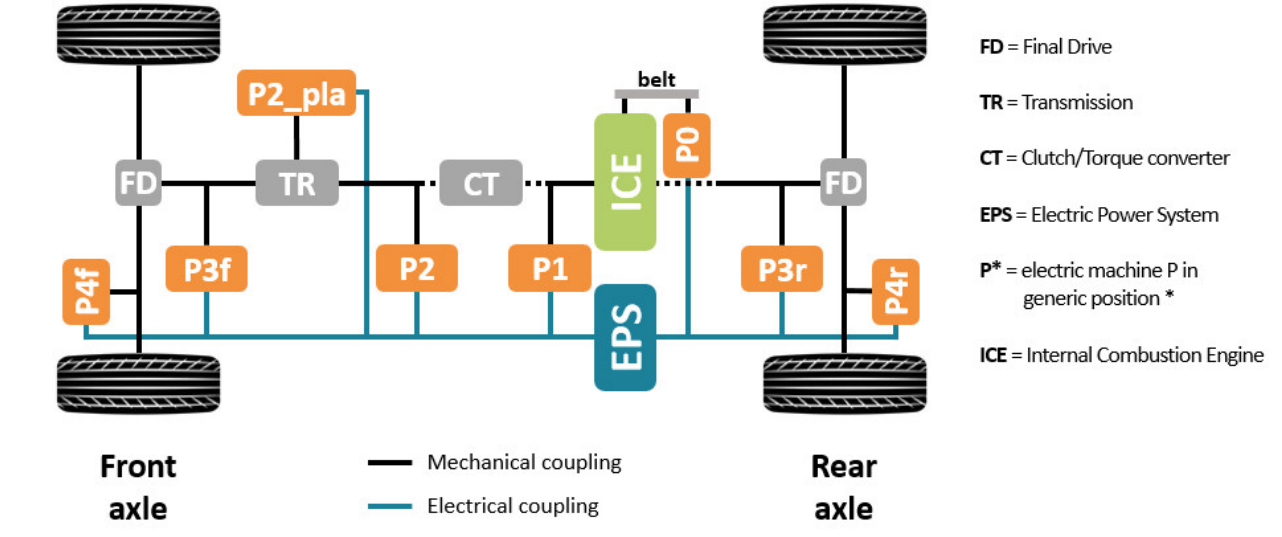
Figure 1. Generic hybrid powertrain model [22].